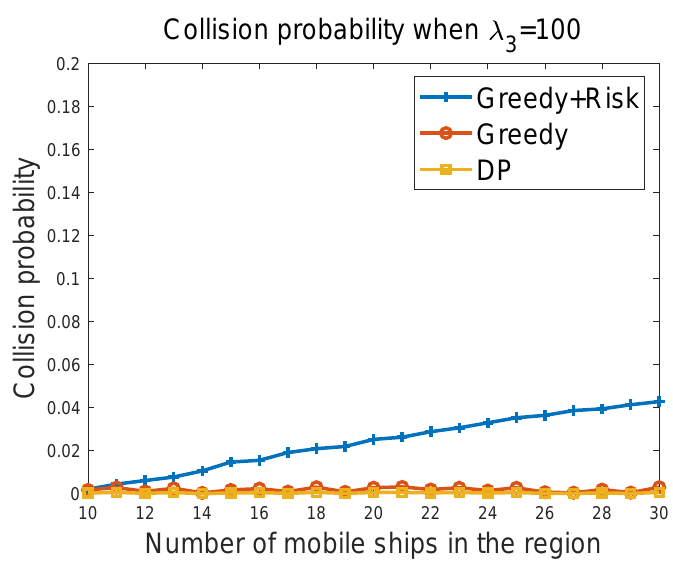
Figure 9. Collision probability vs. ship density when λ 3 =